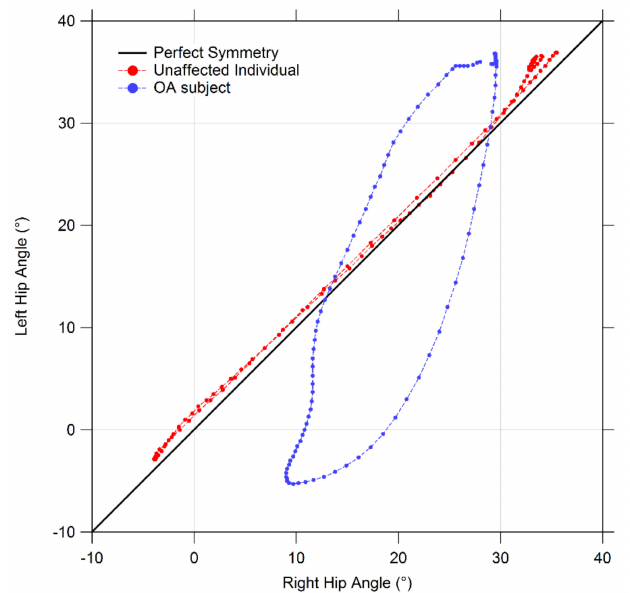
Figure 7. Example of cyclograms for individuals with hip OA and healthy controls.